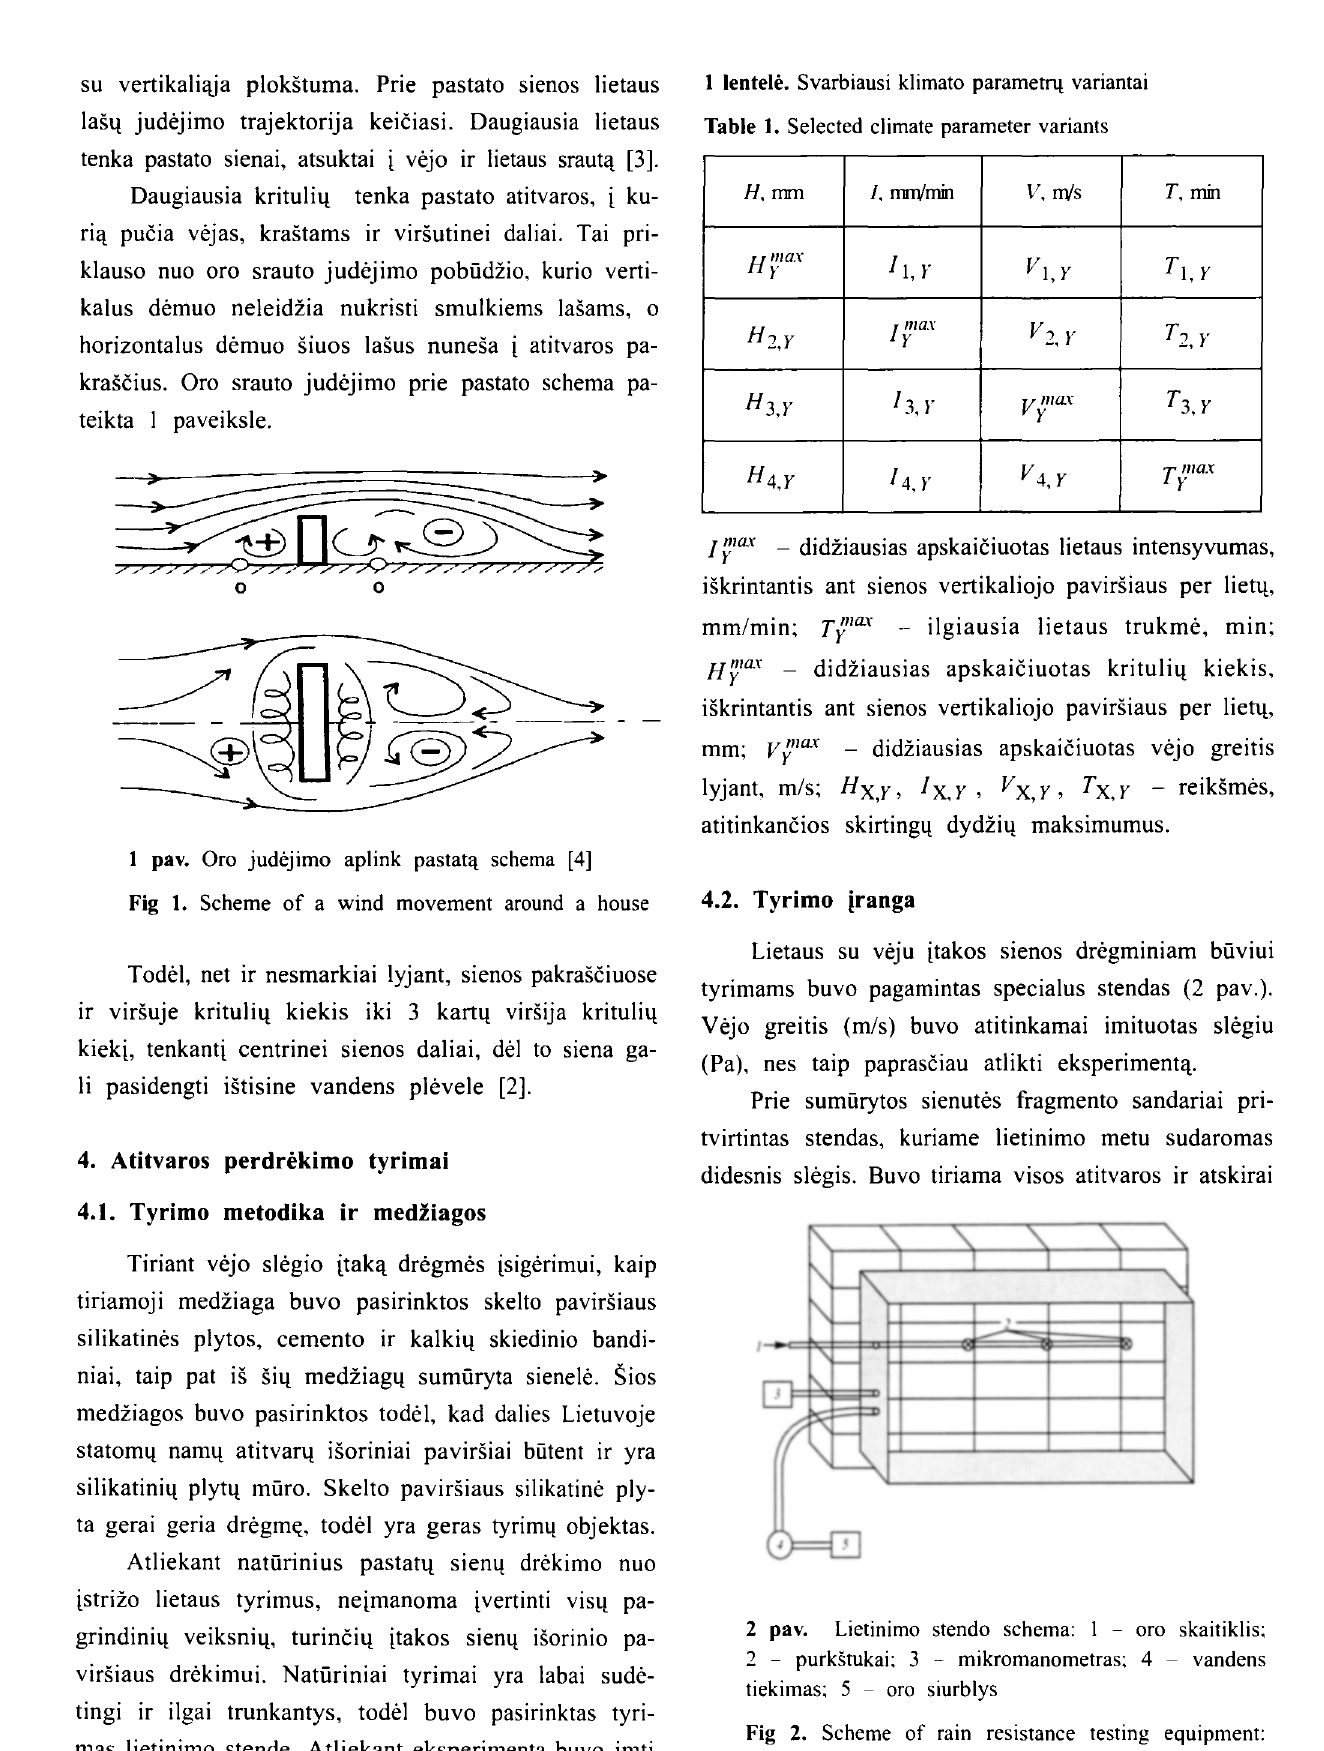
Table 1. Selected climate parameter variants